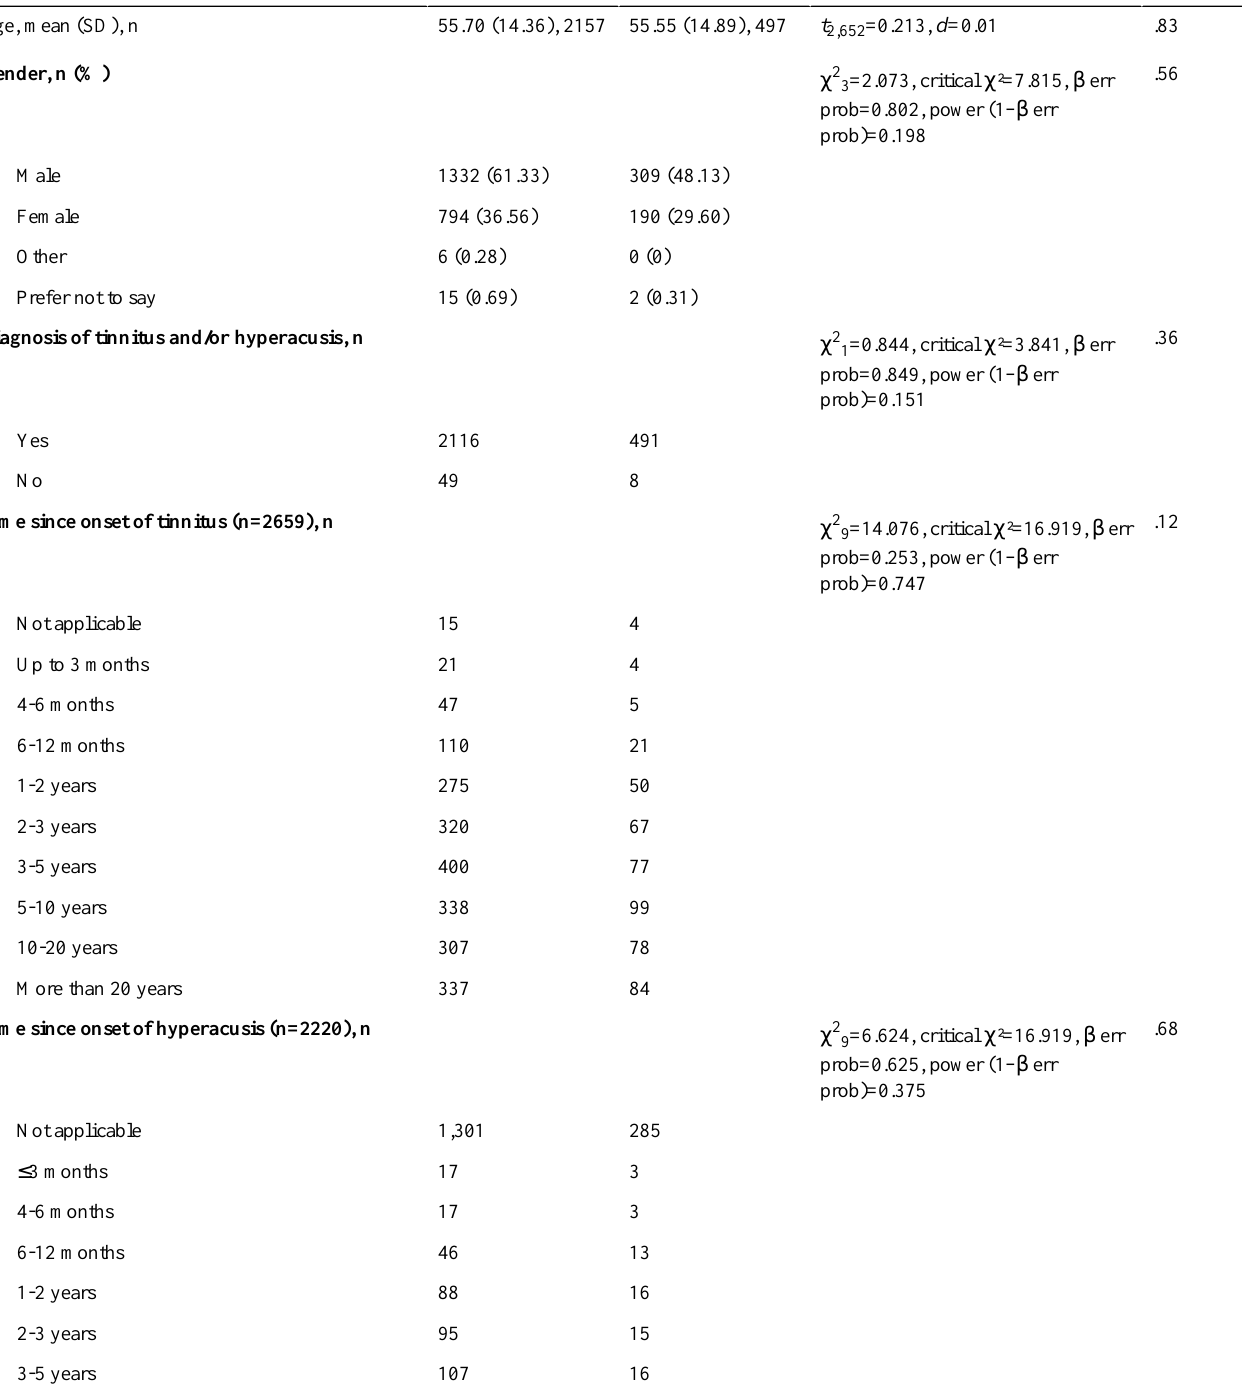
Table 1. Comparison of characteristics of included and excluded